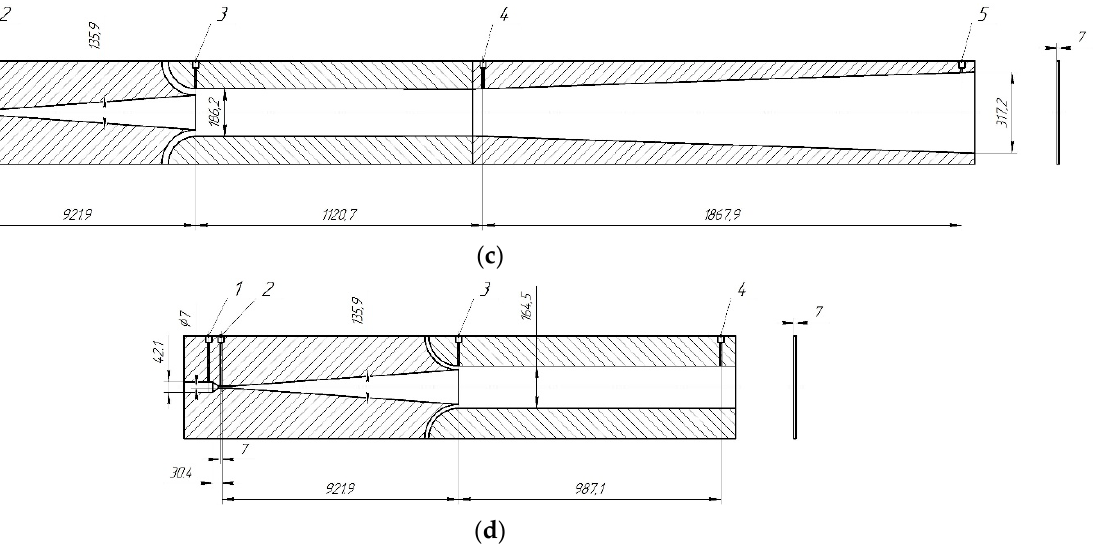
Figure 1. Design schemes of the liquid–vapor ejector with different geometry of the flow part (dimensions in mm): ( a ) with a conical mixing chamber and diffuser; ( b ) with a conical mixing chamber without a diffuser; ( c ) with a cylindrical mixing chamber and diffuser; and ( d ) with a cylindrical mixing chamber without a diffuser; 1–6 are places of pressure measurements.